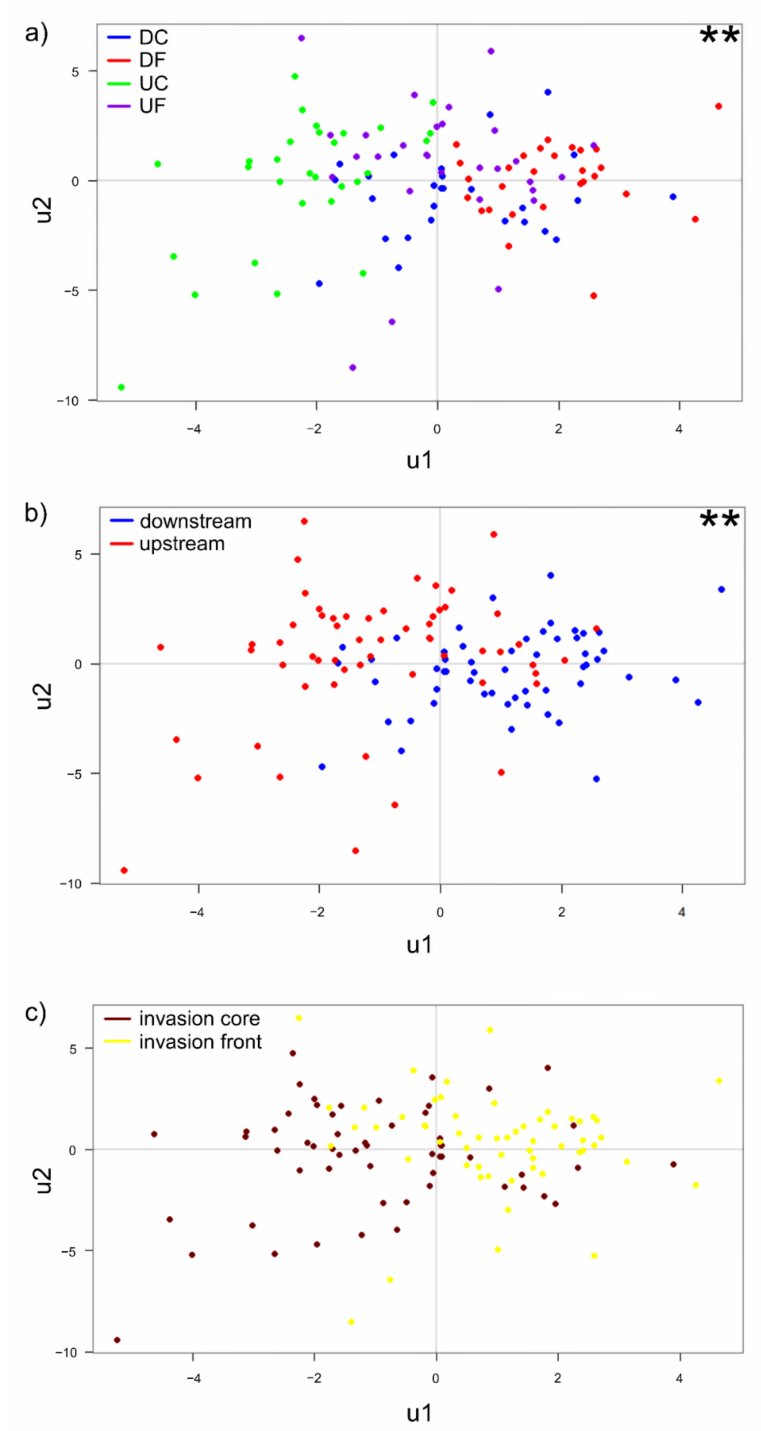
Figure 1. Partial least squares regression (PLS-R) score plots of signal crayfish immune parameters, based on y components (u1 and u2). Plots represent the relationship between response variables (immune parameters) and predictors (water temperature, relative crayfish abundance (CPUE), Ful- ton’s condition factor (FCF), and hepatosomatic index (HSI)) according to sites along invasion range ( a ), upstream and downstream river segments ( b ), and invasion core and front sites ( c ). Significant effect ( p < 0.01) in ‘response-predictor’ relation (performed by using the generalized linear model on PLS-R scores) is indicated with **. DC = downstream invasion core, DF = downstream invasion front, UC = upstream invasion core, UF = upstream invasion